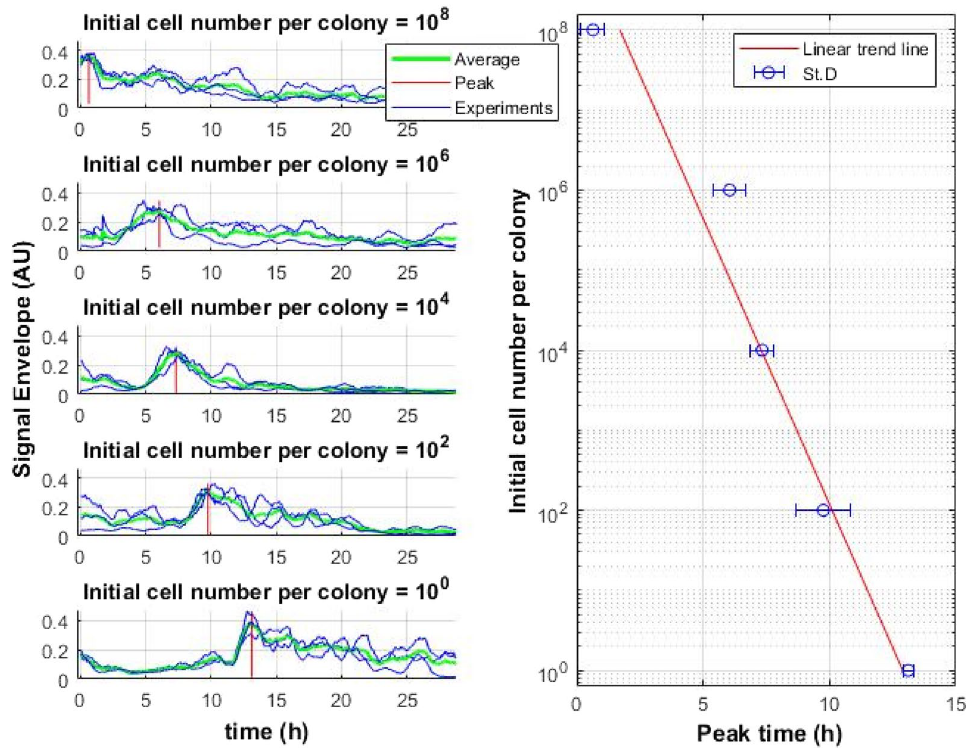
Figure 4. Dependance of the time of the maximum signal value (red lines on the graph on the left and blue circles on the graph on the right) obtained by the laser imaging system on the initial number of E. coli cells in the